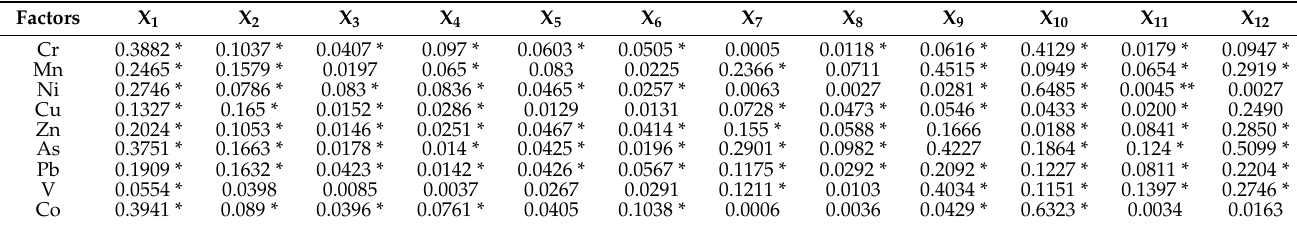
Table 6. Explanatory power (q value) of the studied factors for eight heavy metals in soil.